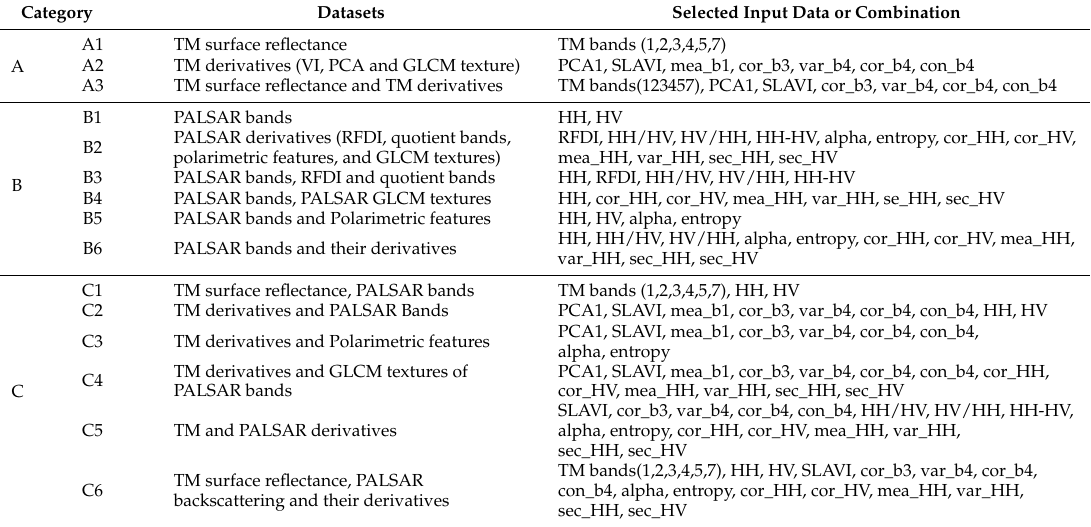
Table 4. Dataset categorization for various classification scenarios. PCA1 stands for the first component of PCA, mea: mean, cor: correlation, var: variance, con: contrast, and sec: second moment are co-occurrence matrix texture